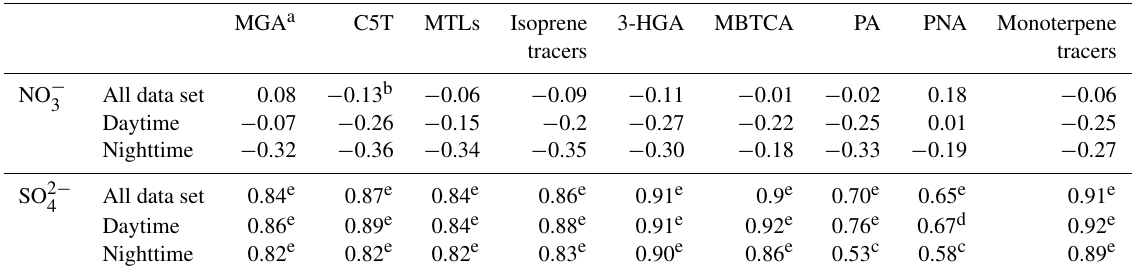
Table 1. Linear correlation coefficients ( r) between secondary organic aerosol tracers and NO − 30 August 2010, Wakayama, central Japan.